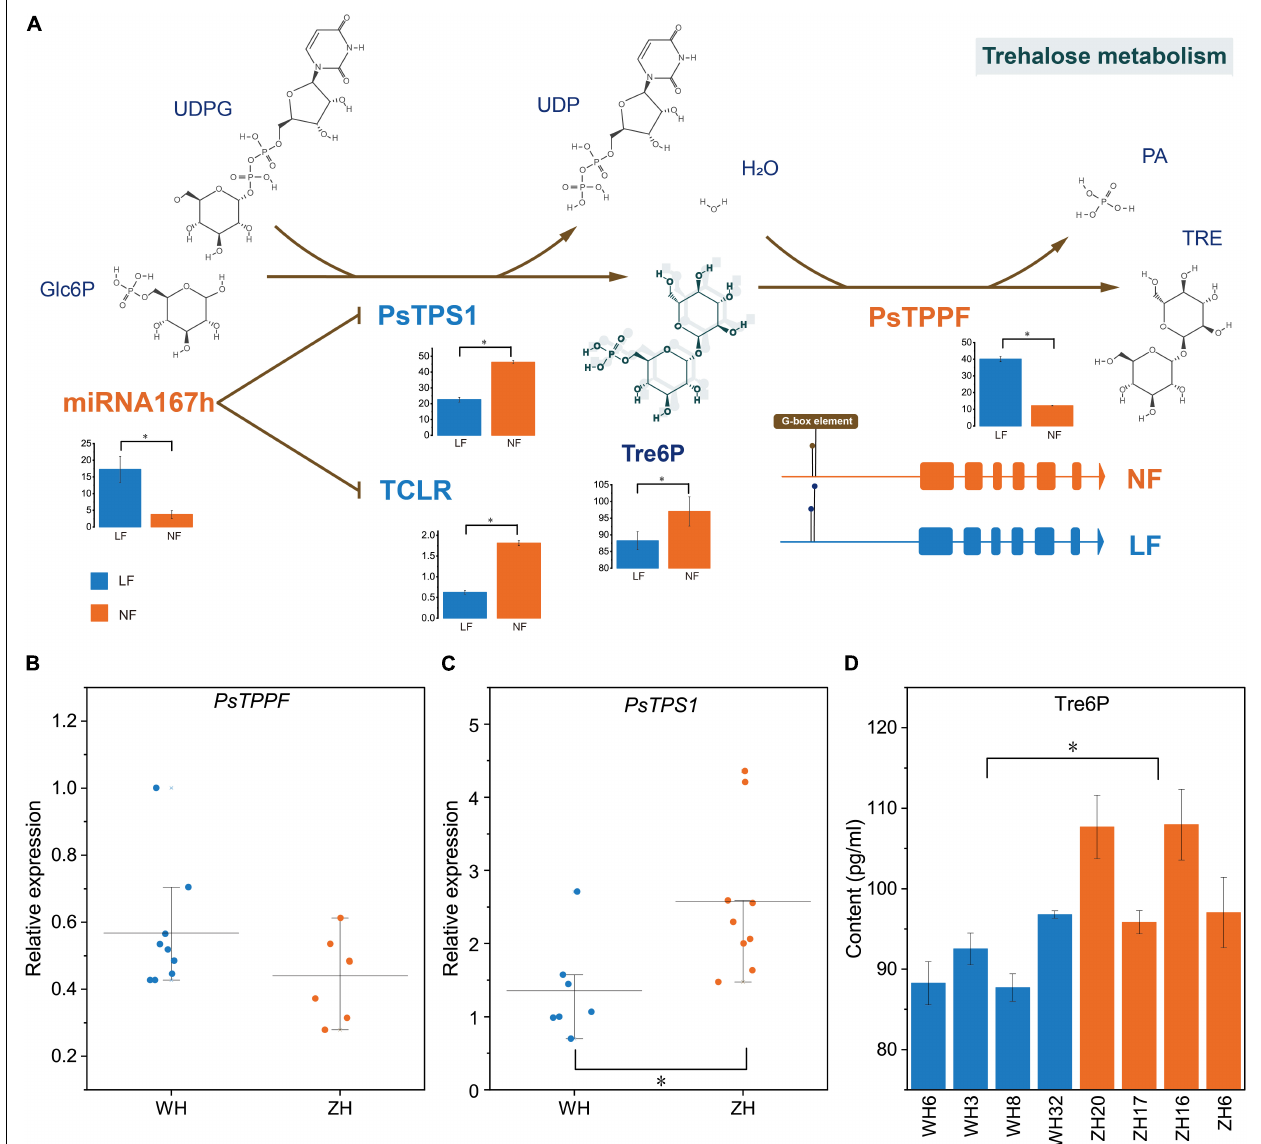
FIGURE 5 | Trehalose-6-phosphate (Tre6P) signaling pathways regulation mechanism. Relative transcript levels of (A) PsTPPF and (B) PsTPS1 , and content of (C) Tre6P in eight randomly selected accessions. (D) CeRNA of Tre6P signaling pathway. Trehalose-6-phosphate synthase (TPS) catalyzes glucose-6-phosphate (Glc6P) and UDP-glucose (UDPG) into Tre6P, and then Tre6P is dephosphorylated into trehalose by trehalose-6-phosphate phosphatase (TPP). PsTPS1 was down-regulated by competitively binding miR167h with TCLR . The histograms were visualized using FPKM of mRNA and lncRNA and TPM of miRNA. H2O: Water. PA, Phosphoric acid; TRE, Trehalose; *, significant differences p <